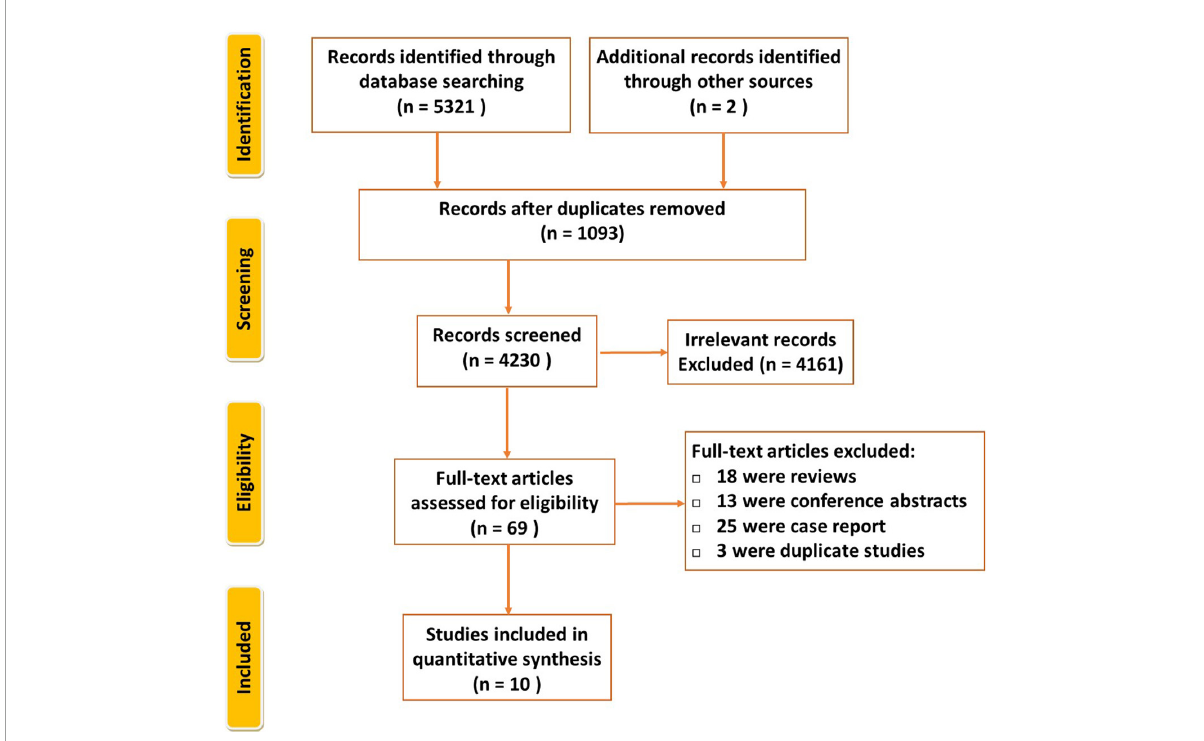
FIGURE1 Flowchart for selection of the included studies.